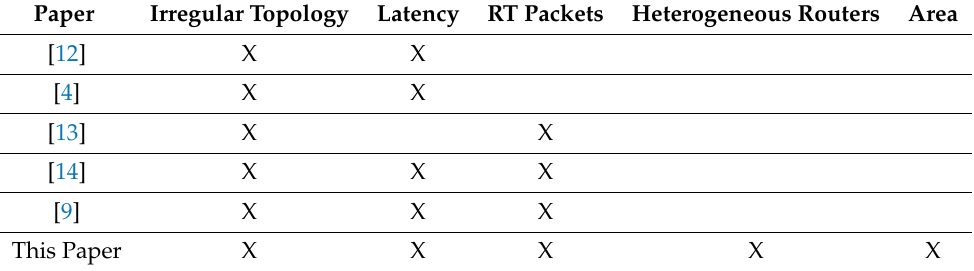
Table 1. Related Works